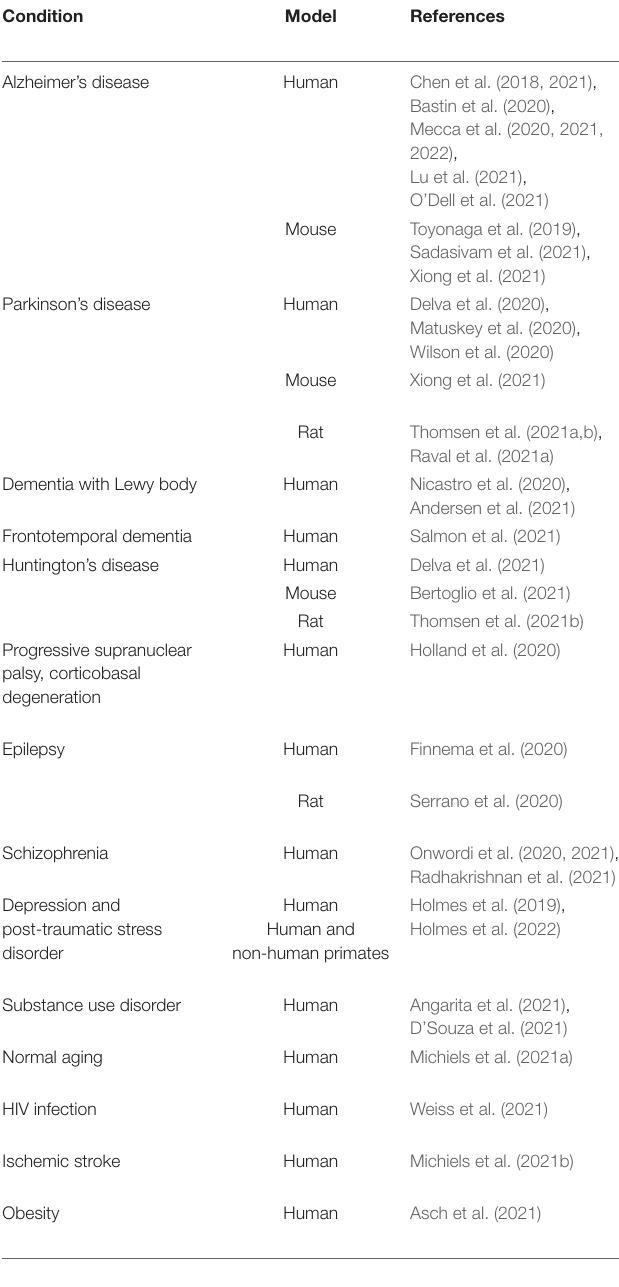
TABLE 2 | Synaptic vesicle glycoprotein 2A (SV2A) density changes detected with positron emission tomography (PET) in different conditions.